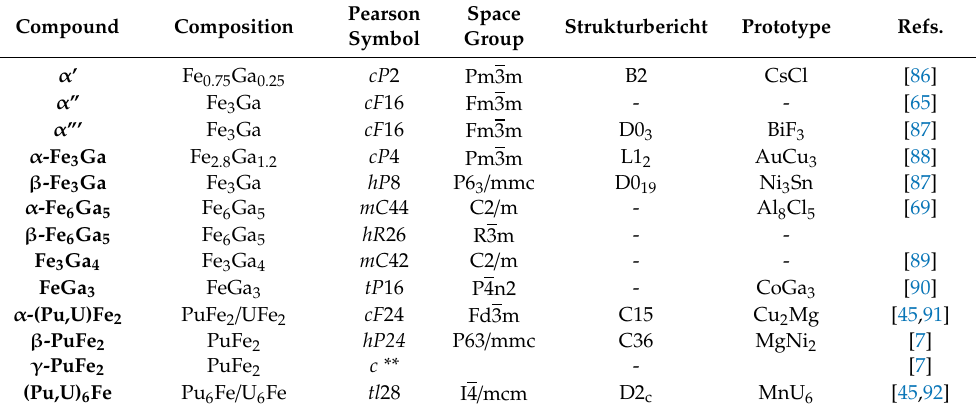
Table 2. Crystal structure of binary systems.